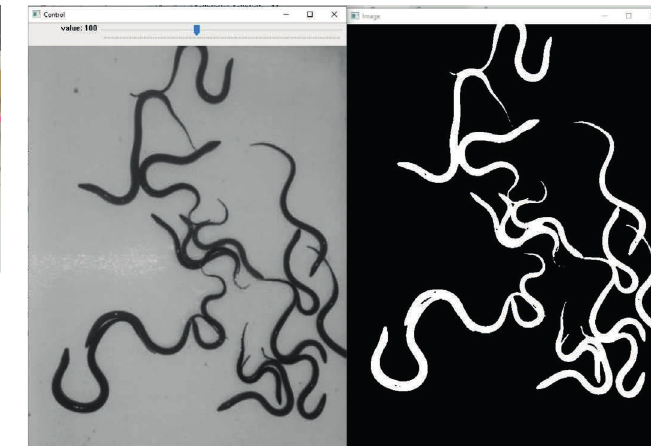
Fig. 5. An illustration of converting the image to binary image using the threshold value of 100.